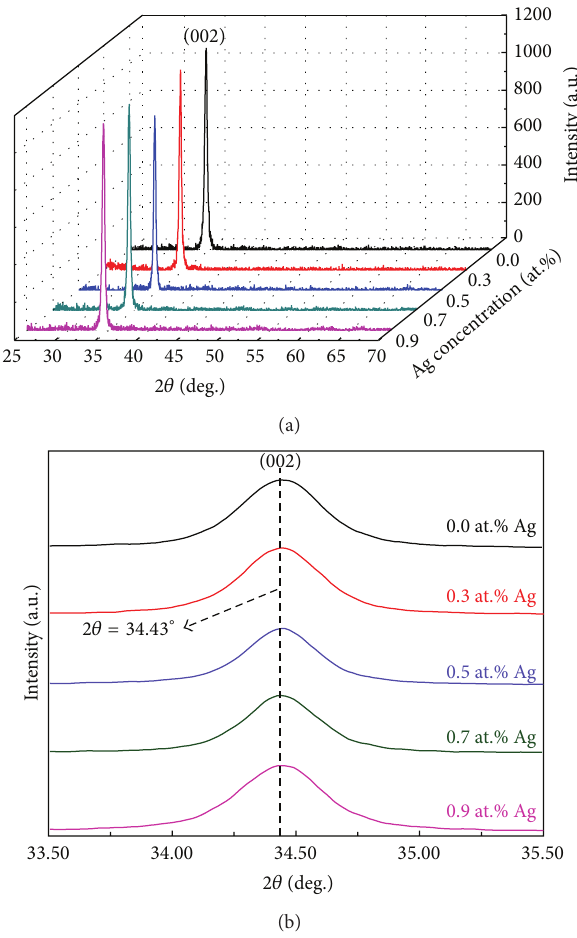
Figure 1: (a) XRD patterns of undoped and Ag doped ZnO thin films and (b) magnified region of (002) peak.